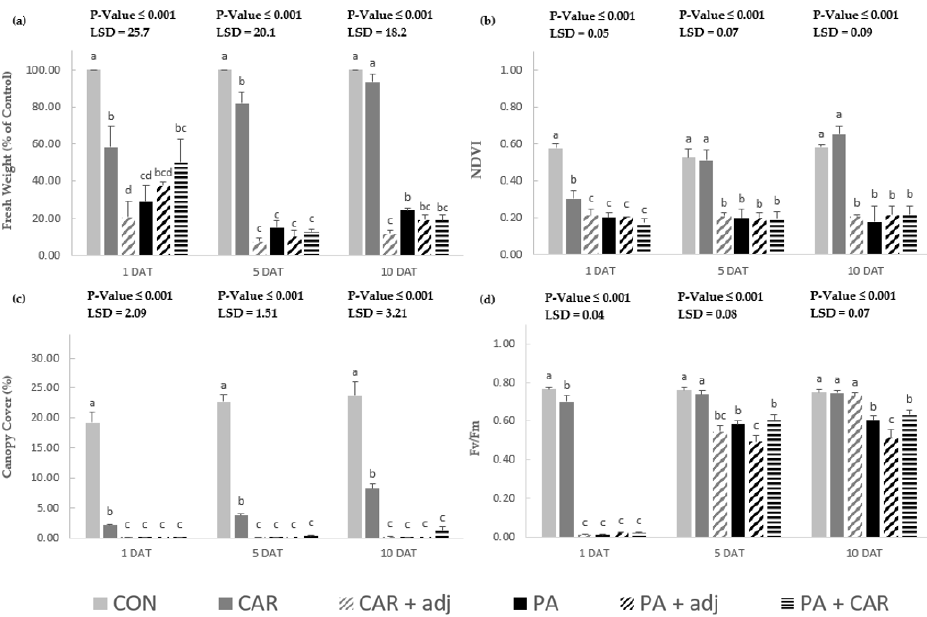
Figure 2. Johnsongrass ( Sorghum halepense (L.) Pers.) ( a ) fresh weight (% of control), ( b ) NDVI, ( c ) canopy cover (%), and ( d ) maximum quantum yield of photosystem II (F v /F m ). Data are shown as pooled over experimental runs and reanalyzed by one-way ANOVA. Treatment means were separated according to Fischer’s least significant difference (LSD test) at a confidence interval of a = 0.05. For each measurement, different lowercase letters indicate significant differences between treatments. Vertical bars indicate standard errors.